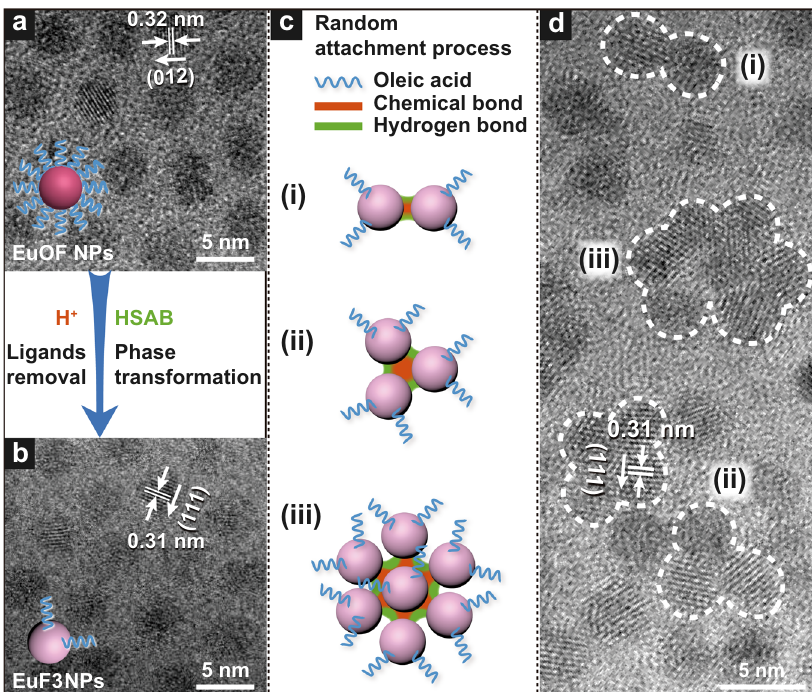
Fig. 1 Self-assembly mechanism of NCs. High-resolution transmission electron microscope (HRTEM) images of a EuOF NPs and b EuF 3 NPs. c Schematic diagram illustrating the structural details, random attachment process, and interaction forces responsible for NCs formation. d HRTEM image taken at assembly time of 15 min. The insets in a and b enlighten the difference of the number of ligand molecules after H + introduction. TEM structures of (i), (ii), and (iii) in d correspond exactly to those in c